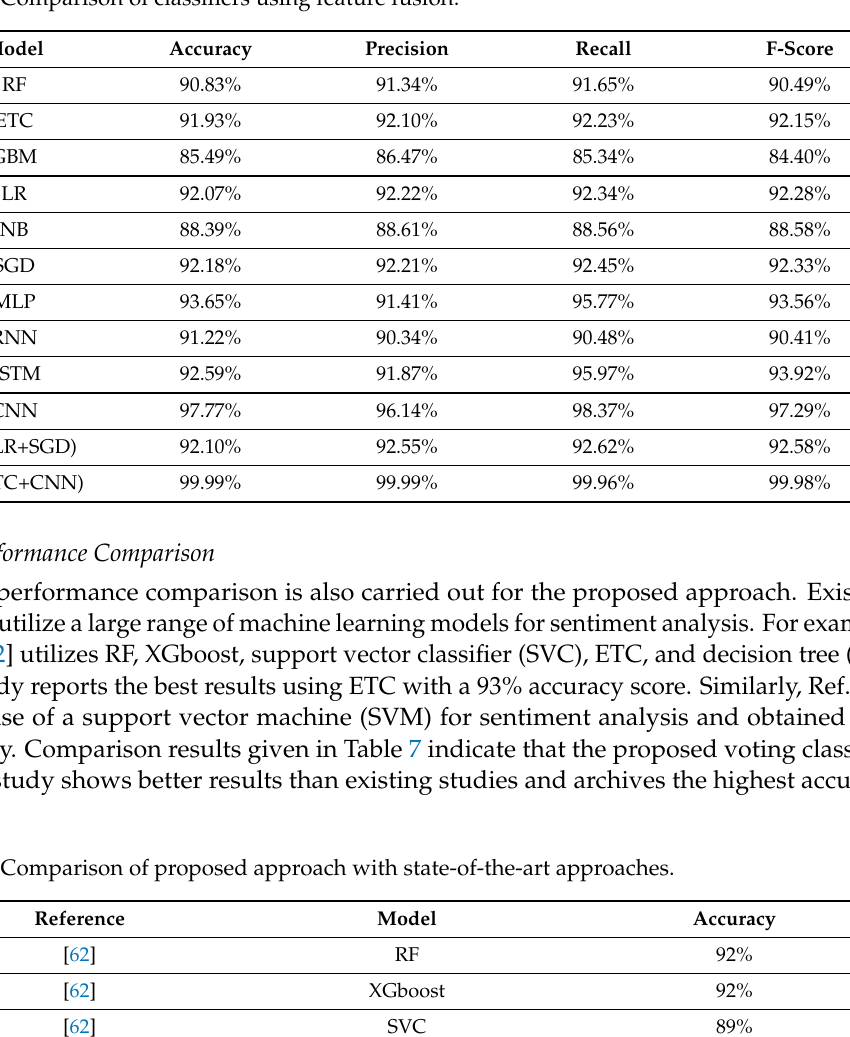
Table 6. Comparison of classifiers using feature fusion.